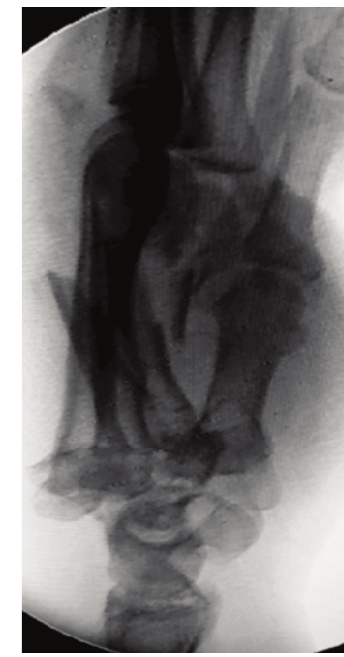
Lateral radiograph view showing Classification Type B.1. Fig. 3: Volar dislocation of multiple metacarpals along with concomitant fracture at the base of ring metacarpal shaft.